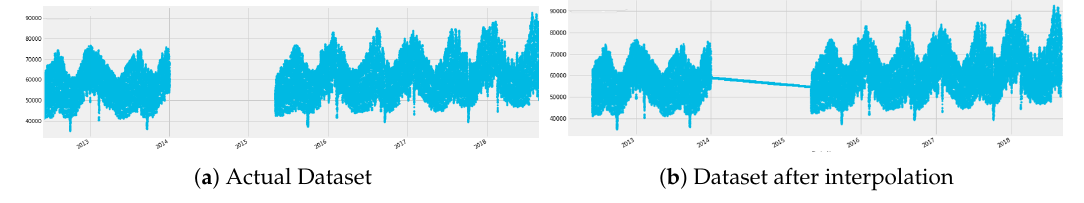
Figure 3. Comparison of data before and after